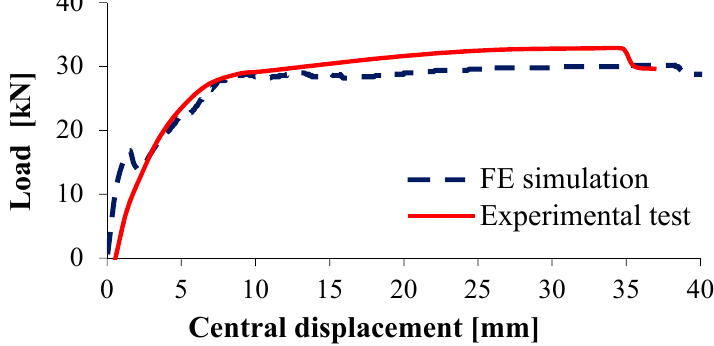
Figure 4. Comparison of load displacement curves at mid-span for 2D FE analysis and experimental results of a corroded RC beam no. 115; experimental data from [30].